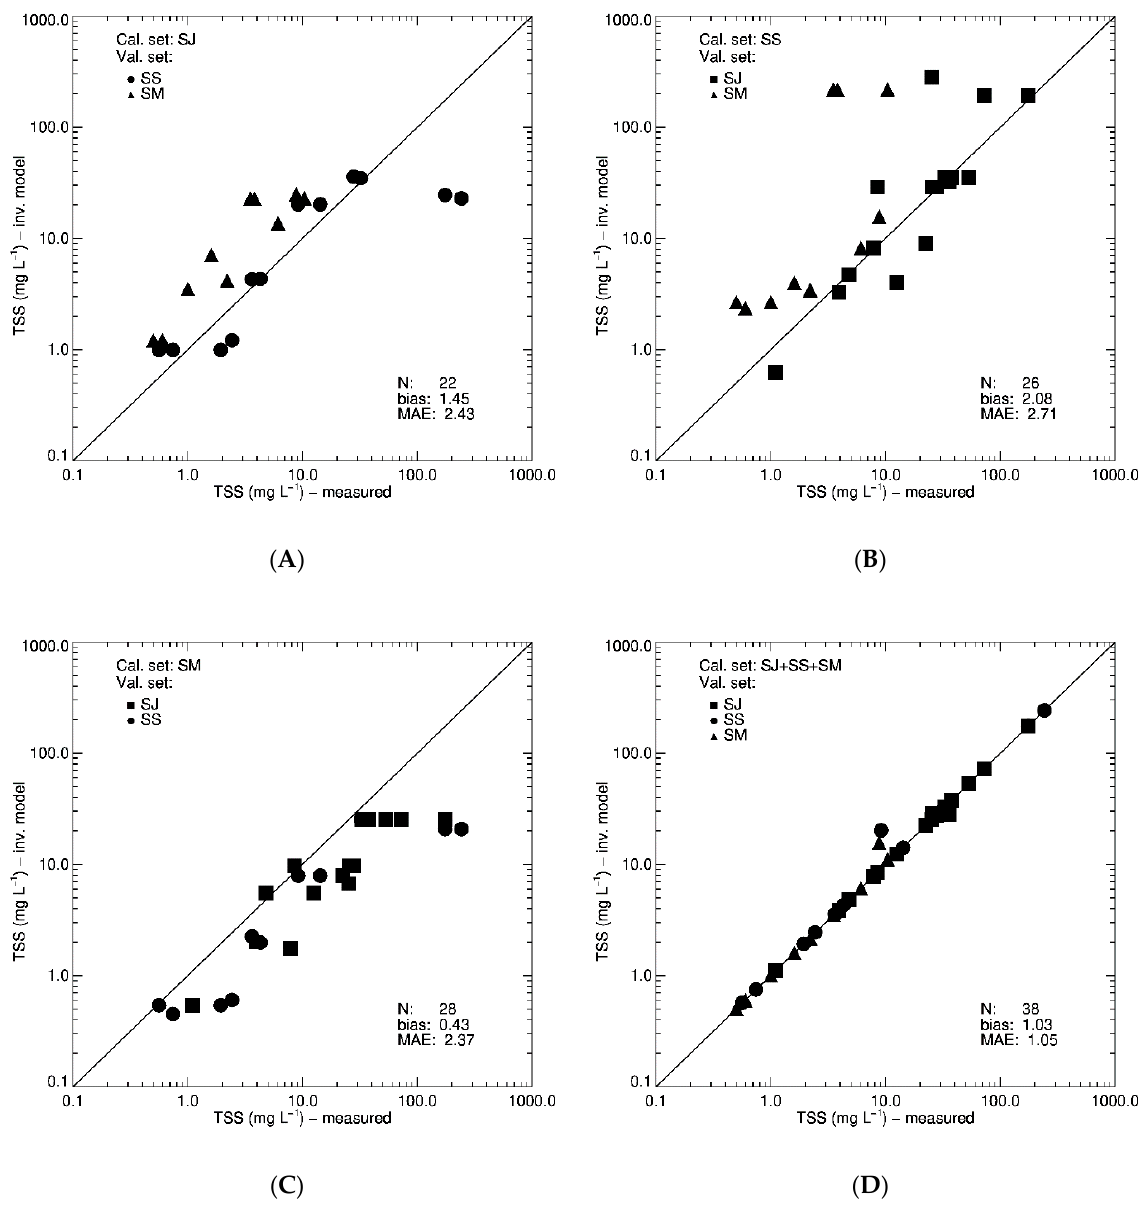
Figure 6. Performance of the optical inversion model for TSS retrieval with changing input members (Calibration set) included in the Sarawak spectral optical library. ( A ) Retrieval comparisons against SS and SM, ( B ) comparisons against SJ and SM, ( C ) comparisons against SJ and SS, and ( D ) comparisons when both the calibration and validation datasets included all available SIOP datasets in SSOL.